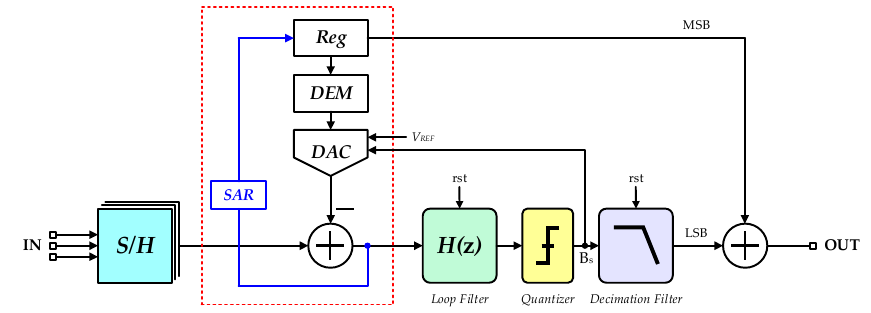
Figure 4. Block diagram of the proposed incremental zoom ADC.